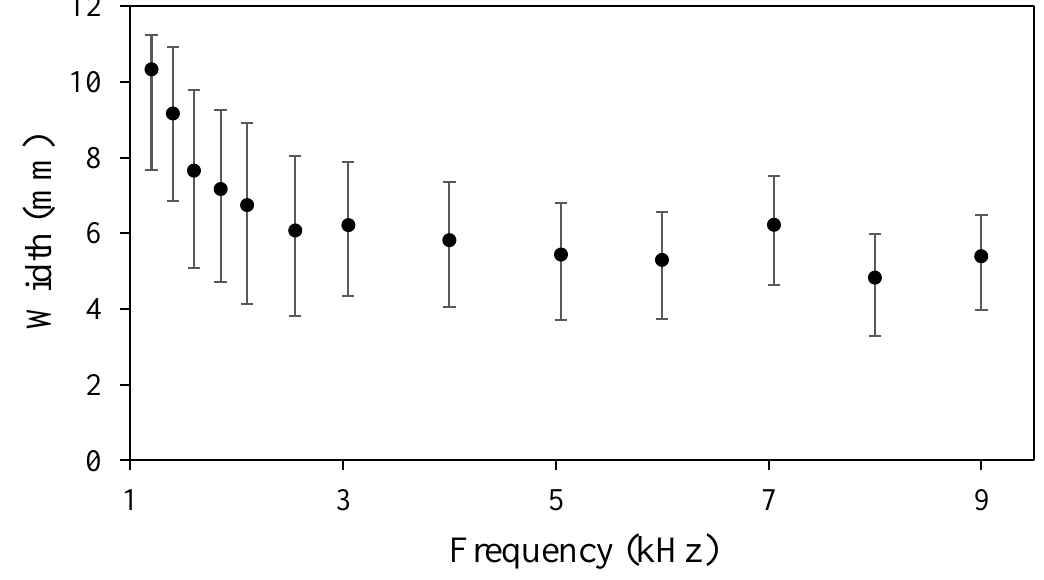
Figure 5. The width (FWHM) of the profiles in the amplitude images representing the recess as a function the rf primary field frequency. The dependence is recorded with the recess covered by a single 0.5mm aluminium